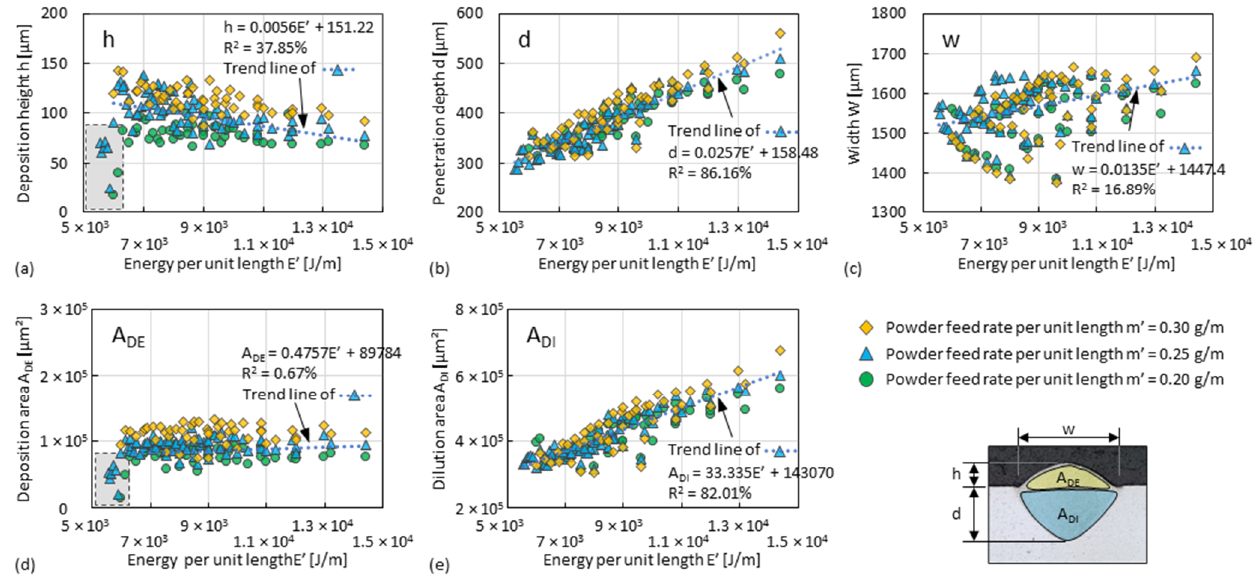
Figure 8 . Plot graphs of ( a ) track height h , ( b ) melt pool depth d , ( c ) track width w , ( d ) cross-sectional area of the deposition zone A DE , and ( e ) cross-sectional area of the dilution zone A DI against energy per unit length E’ with different powder feed rates per unit length m’ . Every point refers to the average value of three measurements. R 2 refers to coefficient of determination for the trend line.